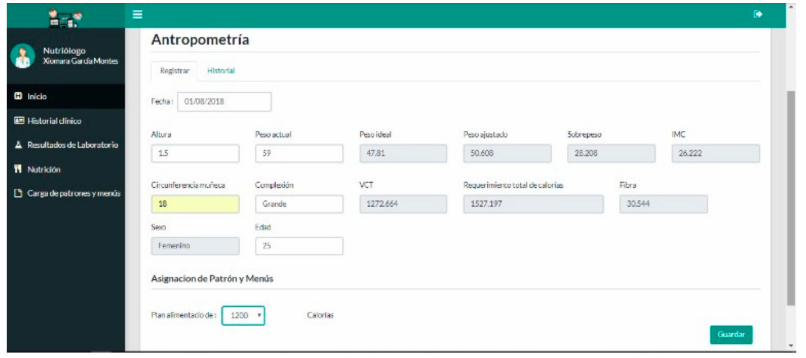
Figure 28. Nutritionist application interface: Anthropometry record.